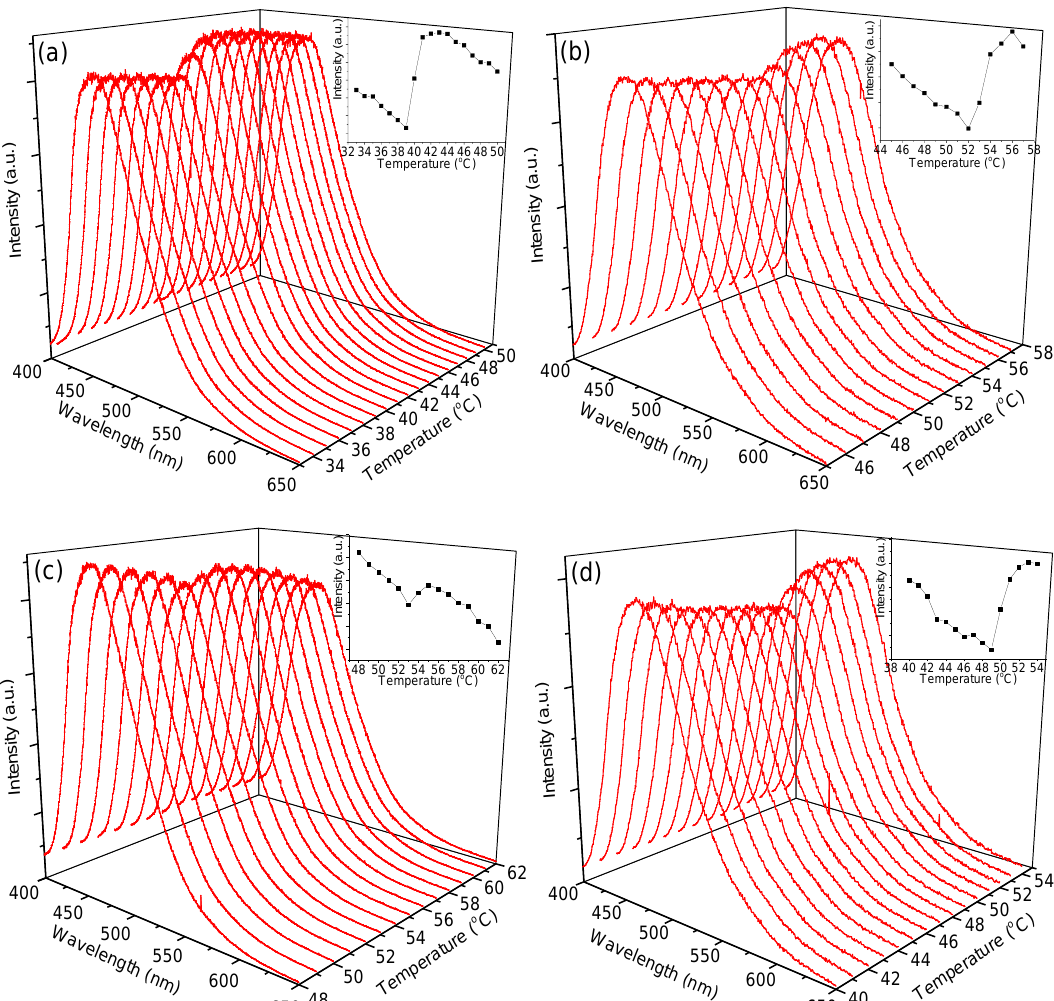
Figure 7. Excimer fluorescent spectra of 5 g/L PDMAA-12.7 copolymers in aqueous solution as a function of temperature ( a ) in the absence of the CD, ( b ) in the presence of equivalent α -CD, ( c ) in the presence of equivalent β -CD and ( d ) in the presence of equivalent γ -CD. Inserts are the curve of the maximum emission intensity related to